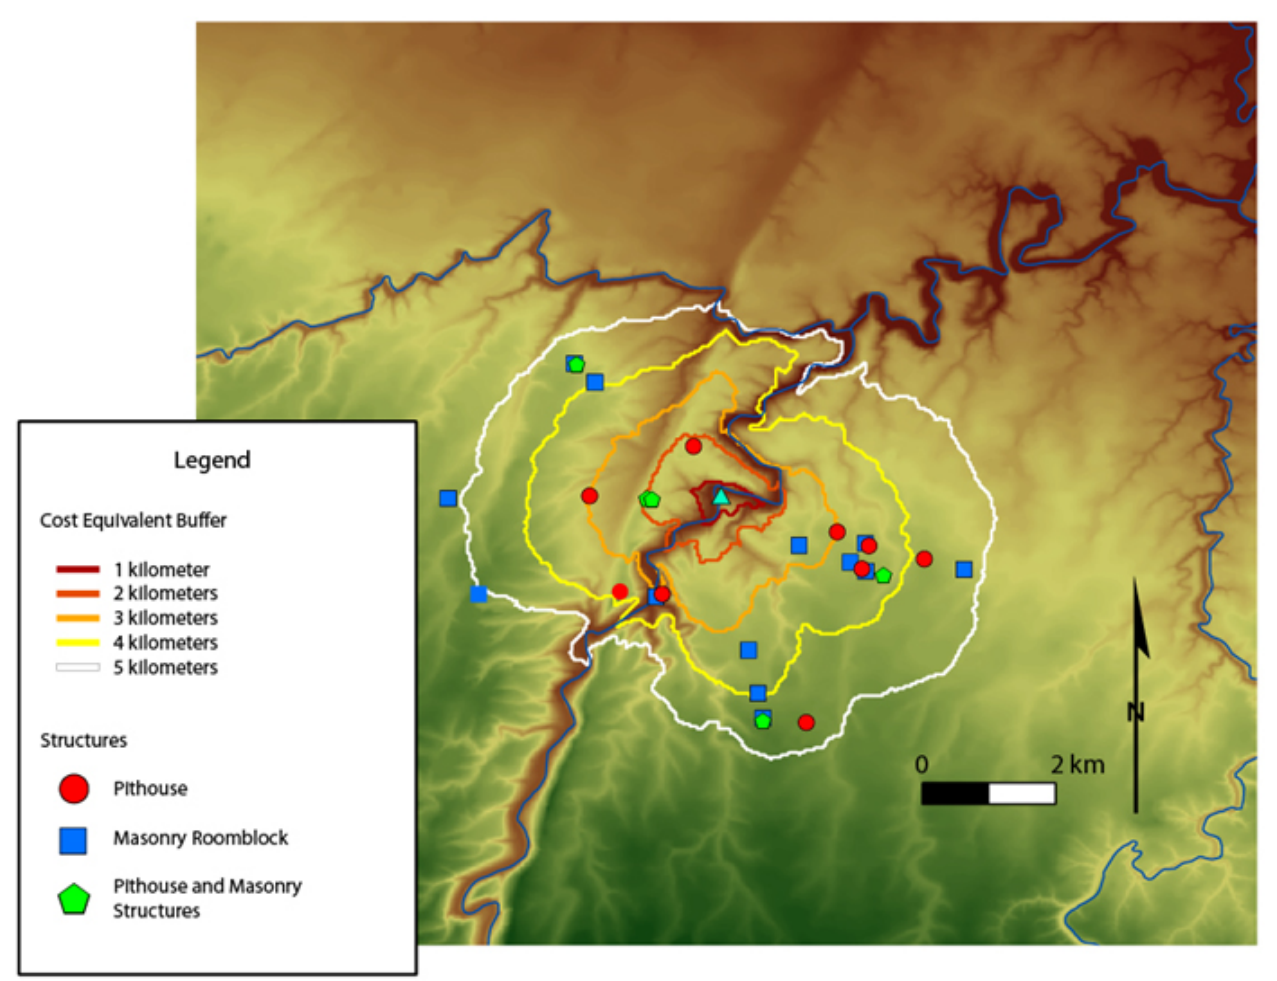
Fig. 5. Locations of structures within survey